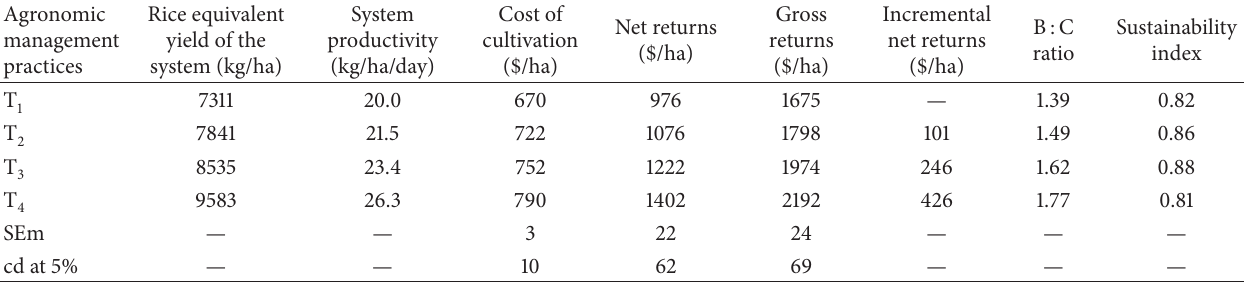
Table 4: Economics of rice-wheat system under different agronomic management practices (pooled data of four years).